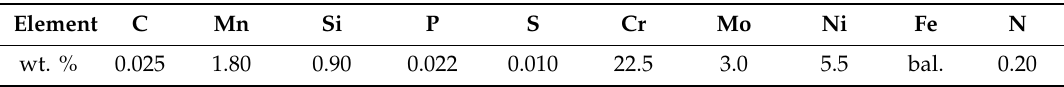
Table 1. Composition by quantometer (analyses performed by Spectromax X) of duplex stainless steel (DSS) 2205 grade stainless steels (in weight %).